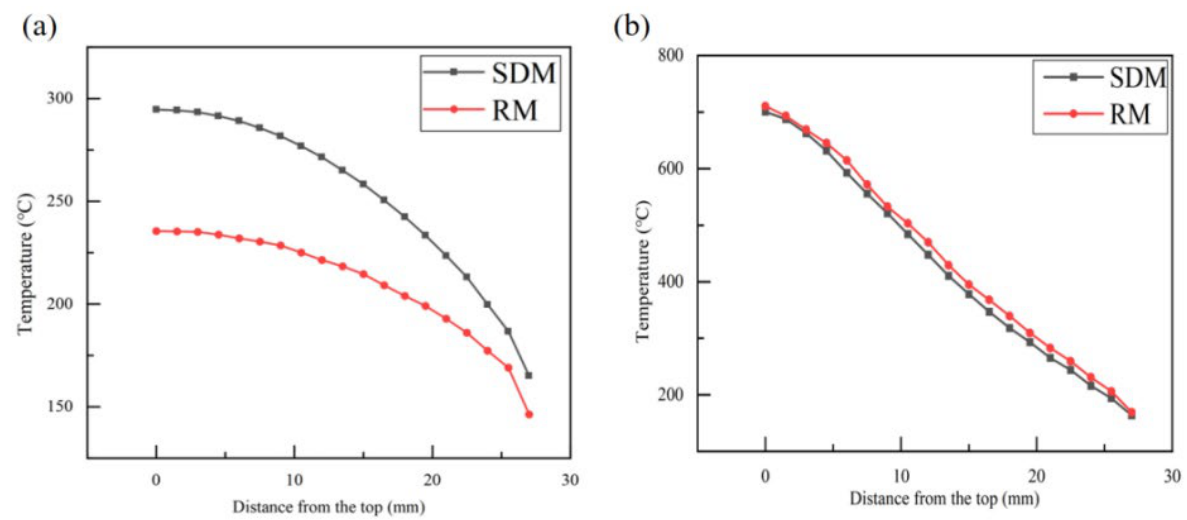
Figure 11. Temperature distribution along the height direction at the left and right end points of the last layer. ( a ) Arc-extinguished end. ( b ) Arc-striking end.